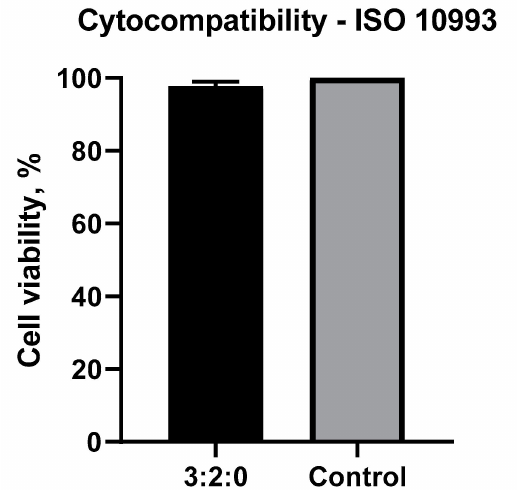
Figure 6. Percentage of cell survival tested on a MC3T3 cell line exposed to an extraction medium from CHT/PCD/CN